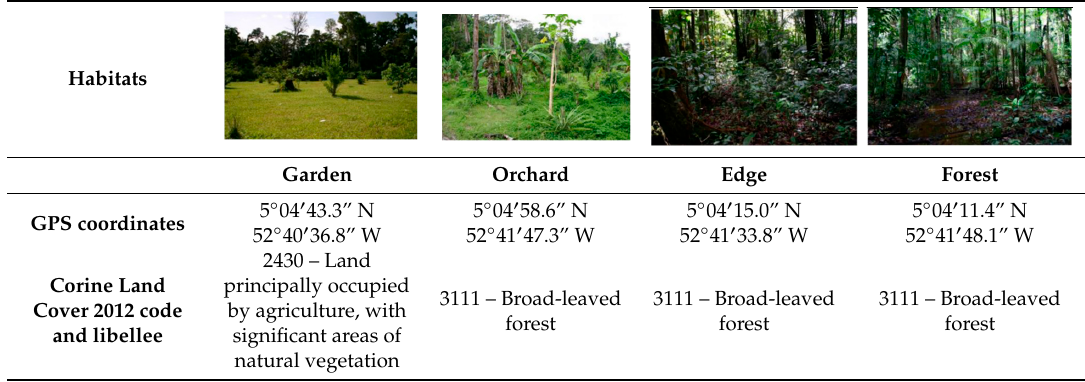
Table 1. Coordinates and Corine Land Cover classes of the four habitats along the habitat complexity gradient. GPS: global positioning system.